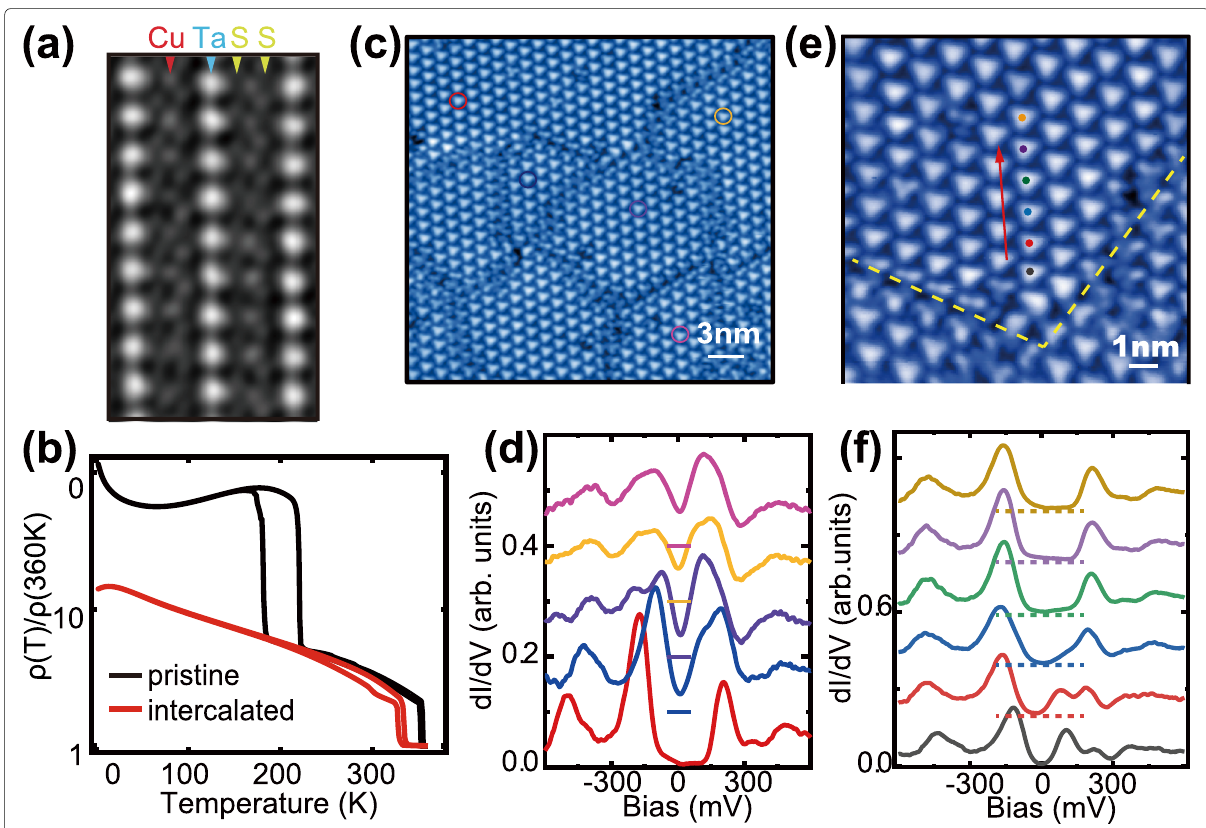
Fig. 10 Copper-intercalated effects in 1 T -TaS 2 . a The atomic resolution ADF-STEM image along [100] direction. b The temperature dependence of resistivity ratio ρ (T)/ ρ (360K) for pristine and Cu intercalated samples. c , d Topography and typical dI / dV spectra of different domains. e , f Topography and a series of dI / dV spectra in an insulating domain. Taken from ref.